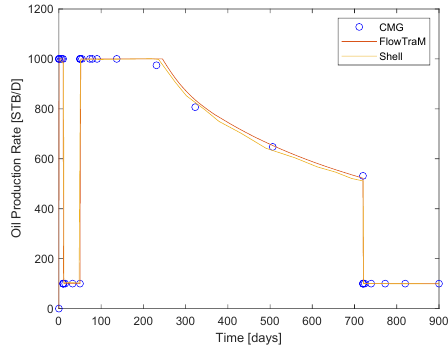
Figure 13. Comparison of oil production rate.